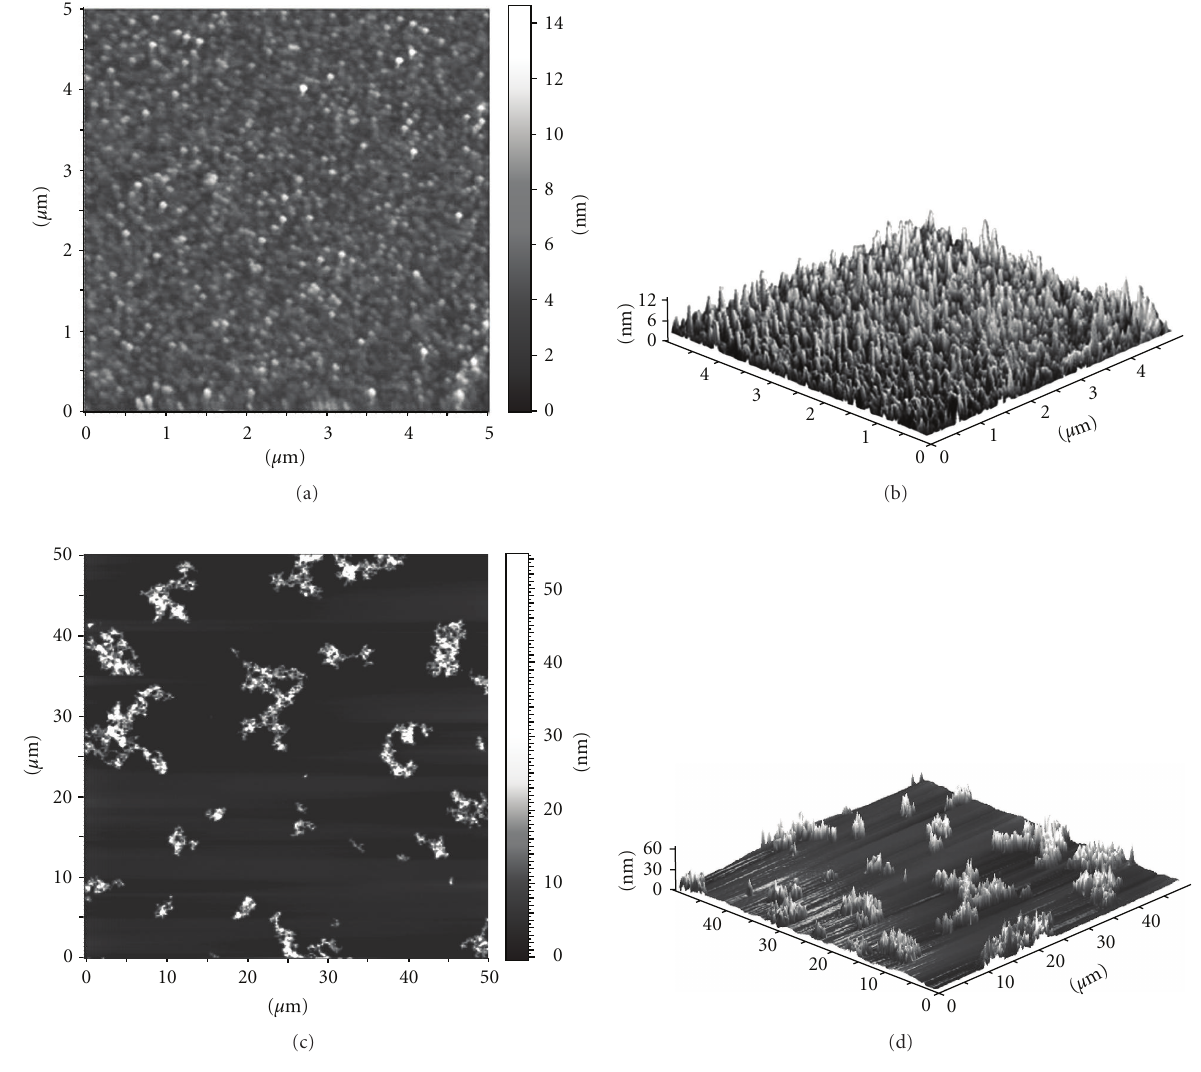
Figure 7: AFM images of anatase sample 3.3: 2D (a) and 3D (b) view of the freshly prepared acid sol; 2D (c) and 3D (d) view of the neutralized